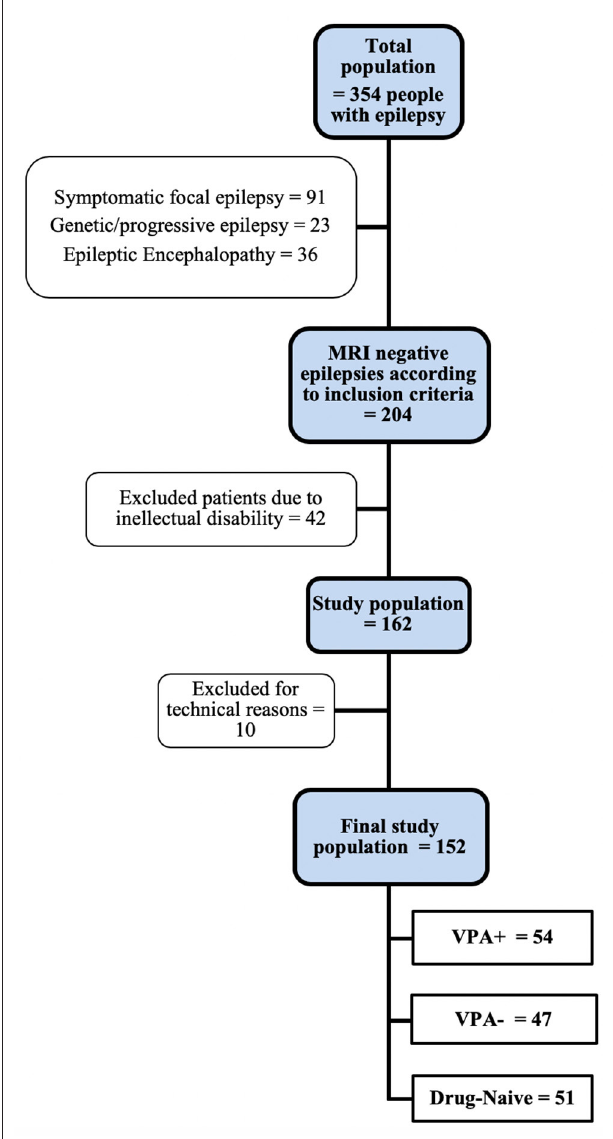
FIGURE 1 | Study flow-chart. See text for inclusion/exclusion criteria. VPA + , patients using valproate at the time of MRI study. VPA-, patients using antiepileptic drugs other than